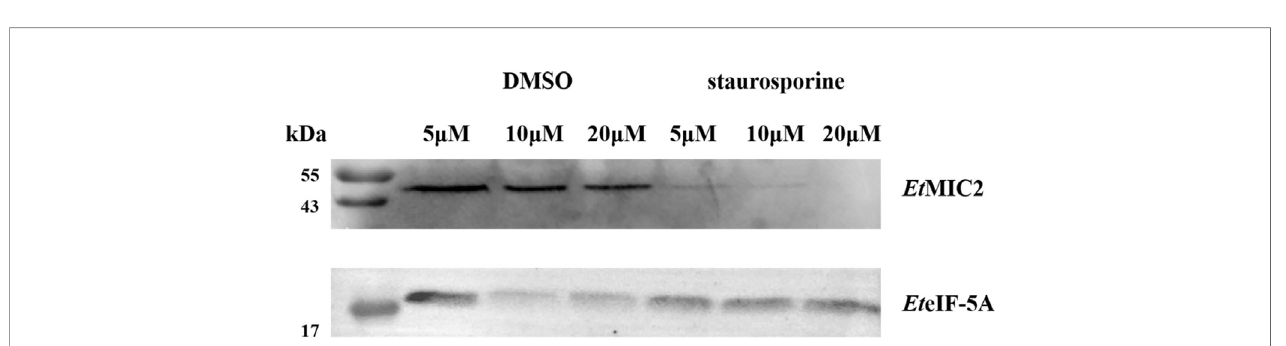
FIGURE 9 | Western blot of secretion experiment. Upper panel: rabbit serum raised against the micronemal protein Et MIC2 (control). Lower panel: rabbit serum raised against the protein Et eIF-5A.